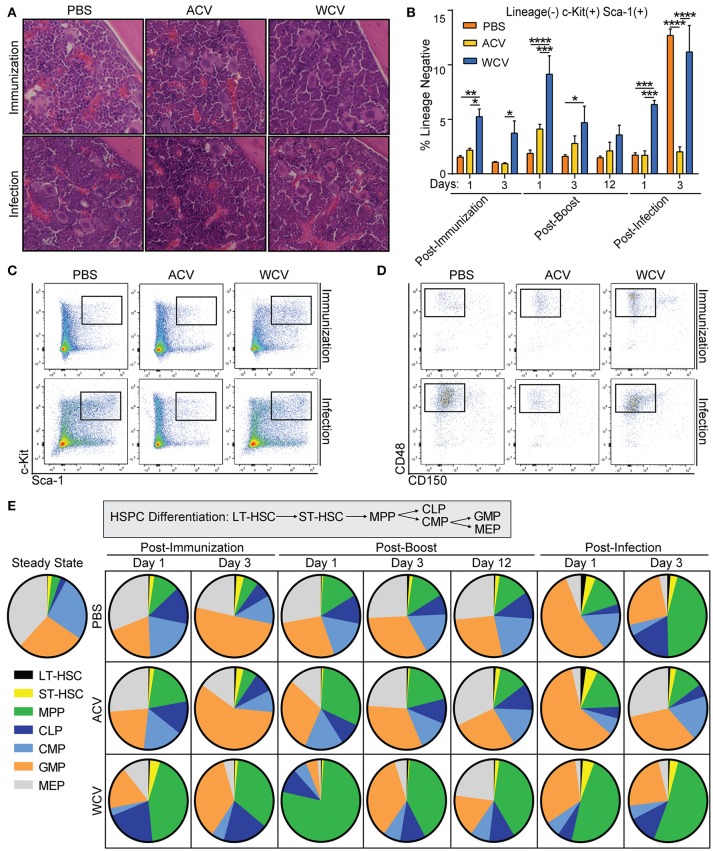
WCV immunization induces MPP expansion in the bone marrow. (A) Representative images of cross sections of tibia from CD-1 mice (n = 4/group for each time point) immunized with phosphate buffered saline (PBS), Bp acellular vaccine (ACV), or Bp whole cell vaccine (WCV) and infected with 107 CFU Bp were taken at 400X magnification. (B) Proportions of lineage−Sca-1+ckit+ (LSK) cells were evaluated in the bone marrow (n = 4/group for each time point) using flow cytometric analysis. (C) Representative dot plots of the flow cytometric analysis from 3B are shown. (D) Representative dot plots from further gating on LSK proportions to show CD48 and CD150 biexponential plot. (E) Hematopoietic stem and progenitor cell proportions were analyzed by flow cytometry and are represented as parts of the whole. *p < 0.05; **p < 0.01; ***p < 0.001; ****p < 0.0001; 2-way ANOVAs with Tukey's multiple comparisons. Error bars are mean ± SEM values.